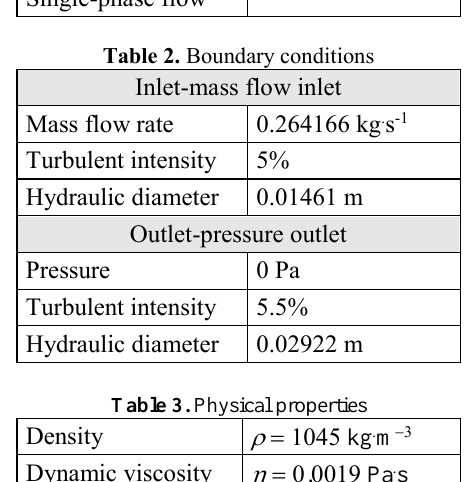
Table 3. Physical